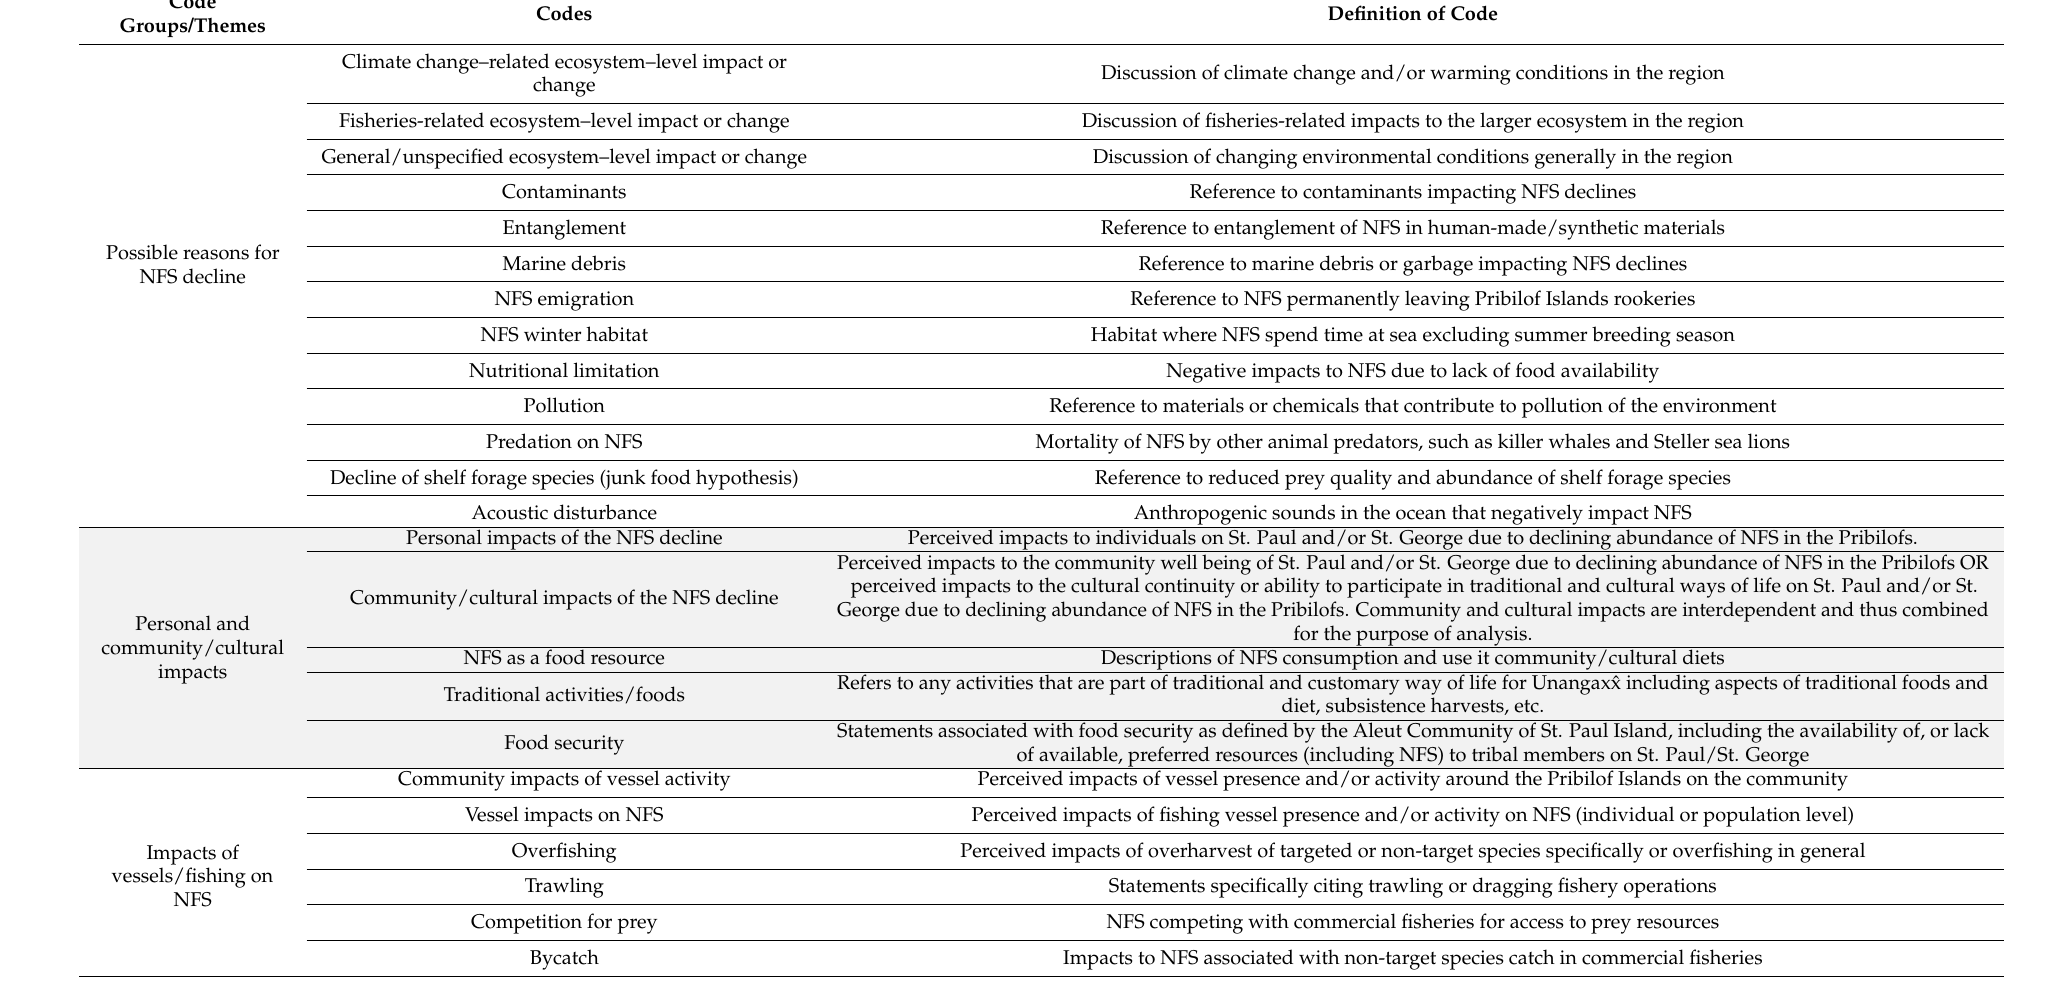
Table A2. Code groups/themes, code names and definitions for Atlas.ti